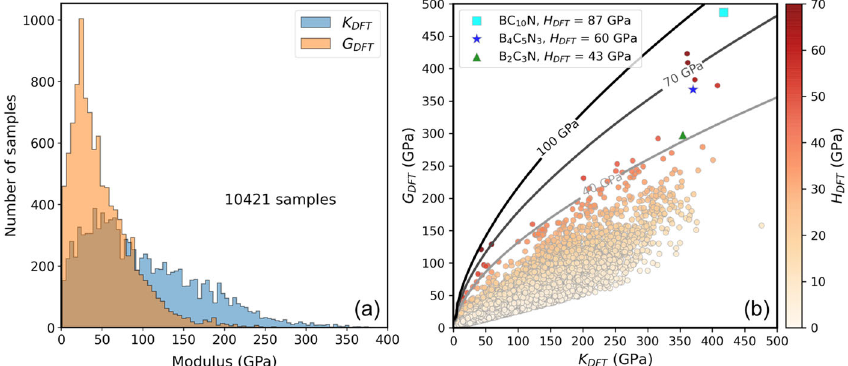
Fig. 2 Target data acquired from the Materials Project database 38 . a Histogram and b scatter plot of bulk ( K ) and shear ( G ) moduli for 10,421 samples based on density functional theory (DFT) calculations. In b , the false-color intensity represents the Vickers hardness ( H ) computed by Tian ’ s empirical model using K and G as inputs. The solid curves represent the hardness contours using Tian ’ s model 43 . These contour lines can help quickly locate compounds with superhardness, with the caveat that the model ’ s applicability might be more limited in the low-bulk/low-shear modulus region. The three proposed superhard compounds BC 10 N, B 4 C 5 N 3 , and B 2 C 3 N are highlighted respectively by the □ , ☆ , and △